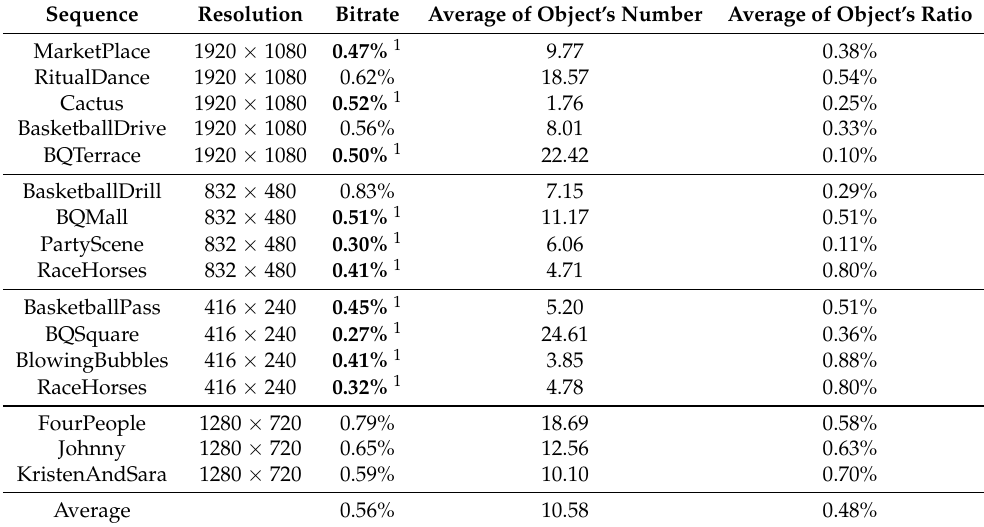
Table 9. Results between the bitrate and the average object’s number, object’s ratio when DT model sets α as 0.5.